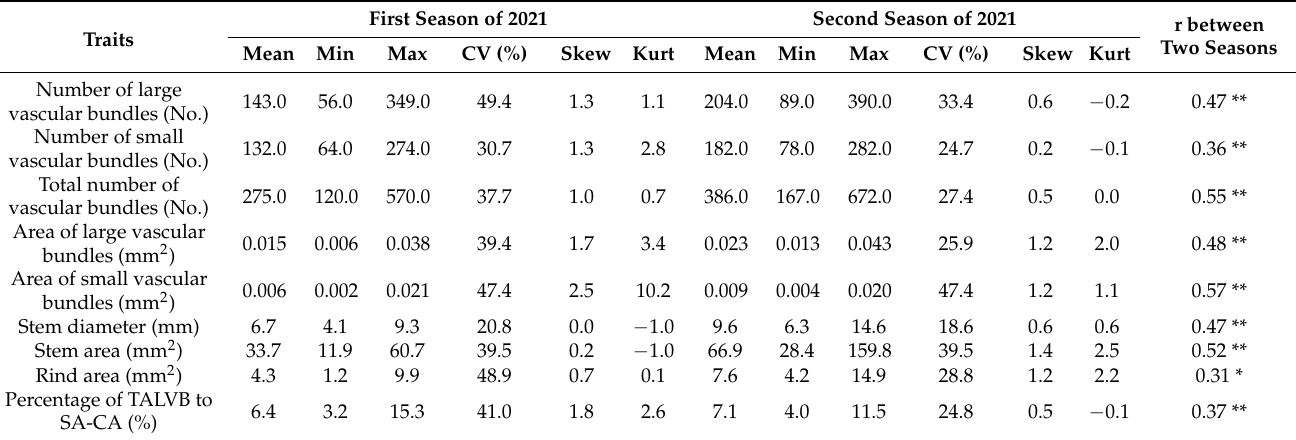
Table 3. Statistics of stem cross-sectional parameters of sorghum germplasm